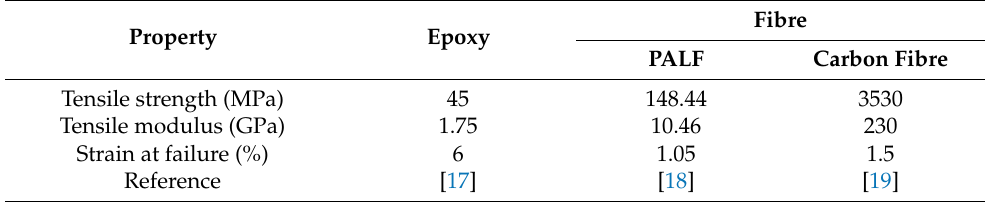
Table 1. Mechanical properties of the constituent fibres and matrix polymers. Property